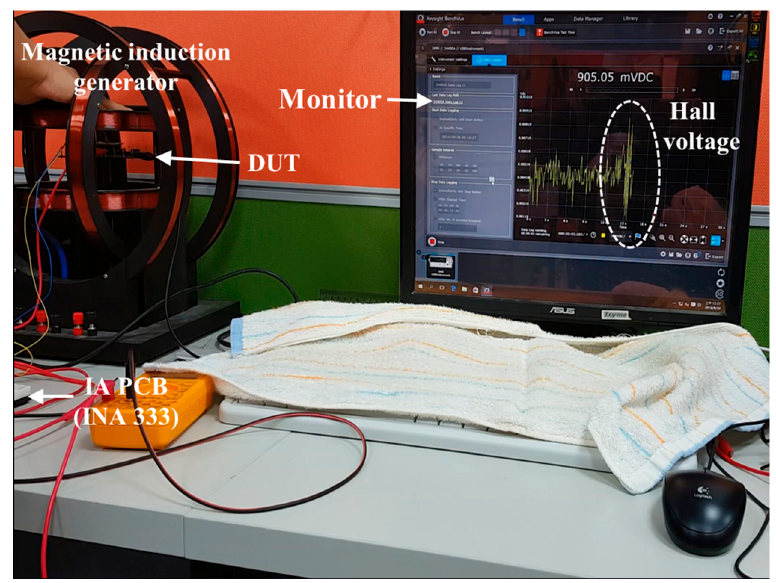
Figure 7. Hall voltage appears on the monitor evidently when the magnetic body comes in contact with the distance